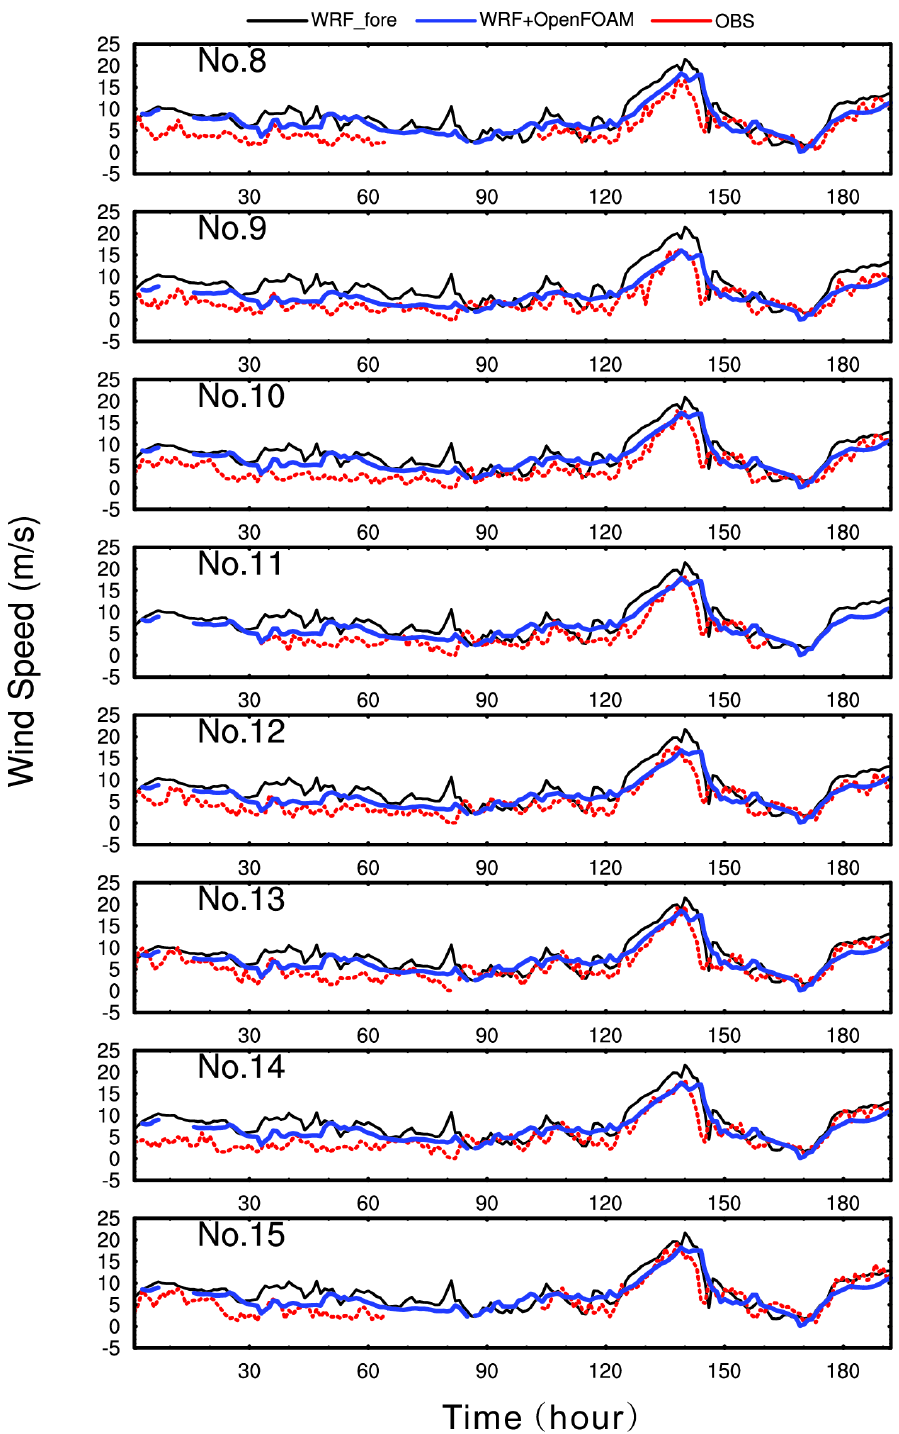
Figure 4. Same as the Figure 3, but for the turbines from No. 8 to No.